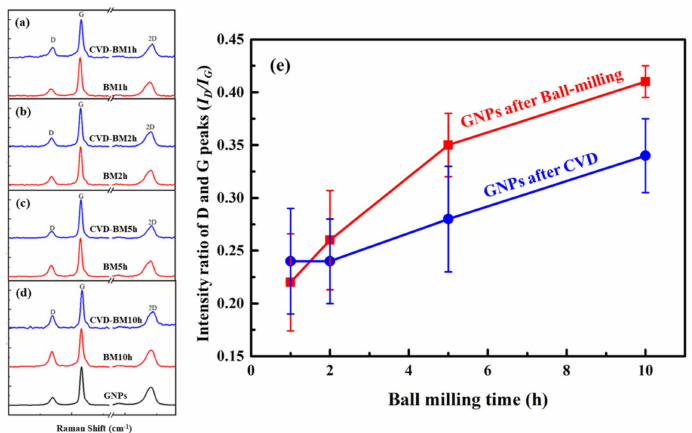
Figure 6. Raman characterization of GNPs after ball milling and CVD repair. ( a – d ) Raman characteri- zation curve of GNPs after ball milling for 1 h, 2 h, 5 h, 10 h and CVD repair; ( e ) The I D / I G variation law of GNPs at different milling